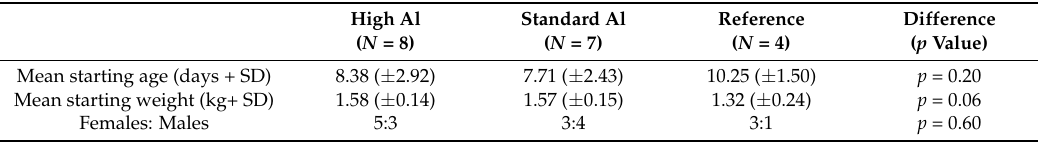
Table 1. Characteristics of the study population and ANOVA